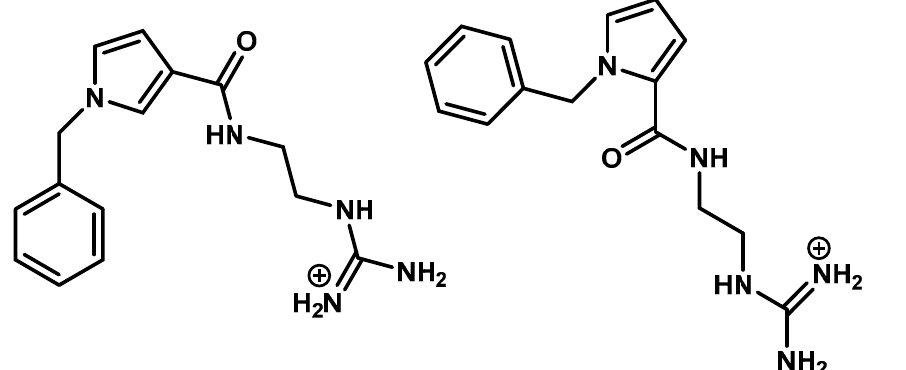
9 of 15 Figure 6. Structures of Myriocin (left) and FTY720 (right). Figure 7. Structure of monomethyl fumarate. Searching the literature, there is only one publication that claims the discovery of non-peptide mimetic molecules derived directly from peptides. The example is referred to the conformational analysis of MBP 83–96 epitope. The authors searched for molecules that inhibit the trimolecular complex formation and consequently the proliferation of ac- tivated T-cells. They generated a structure-based pharmacophore and used ZINC as a